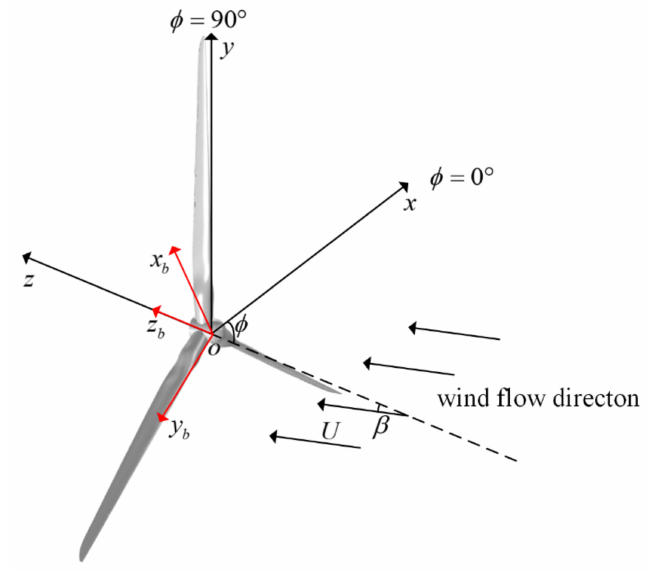
Figure 1. Wind turbine rotor coordinate system.